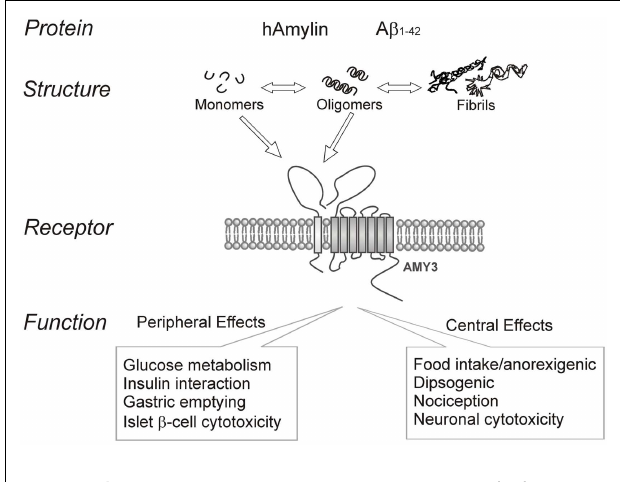
FIGURE 1 | Summary of human amylin and amyloid-beta (A β ) interactions with the amylin receptor (AMY3) and functional consequences of such interactions at the peripheral and central levels